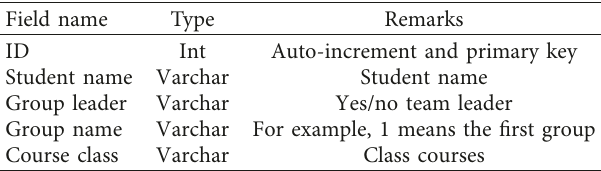
Table 5: Detailed allocation of groups.